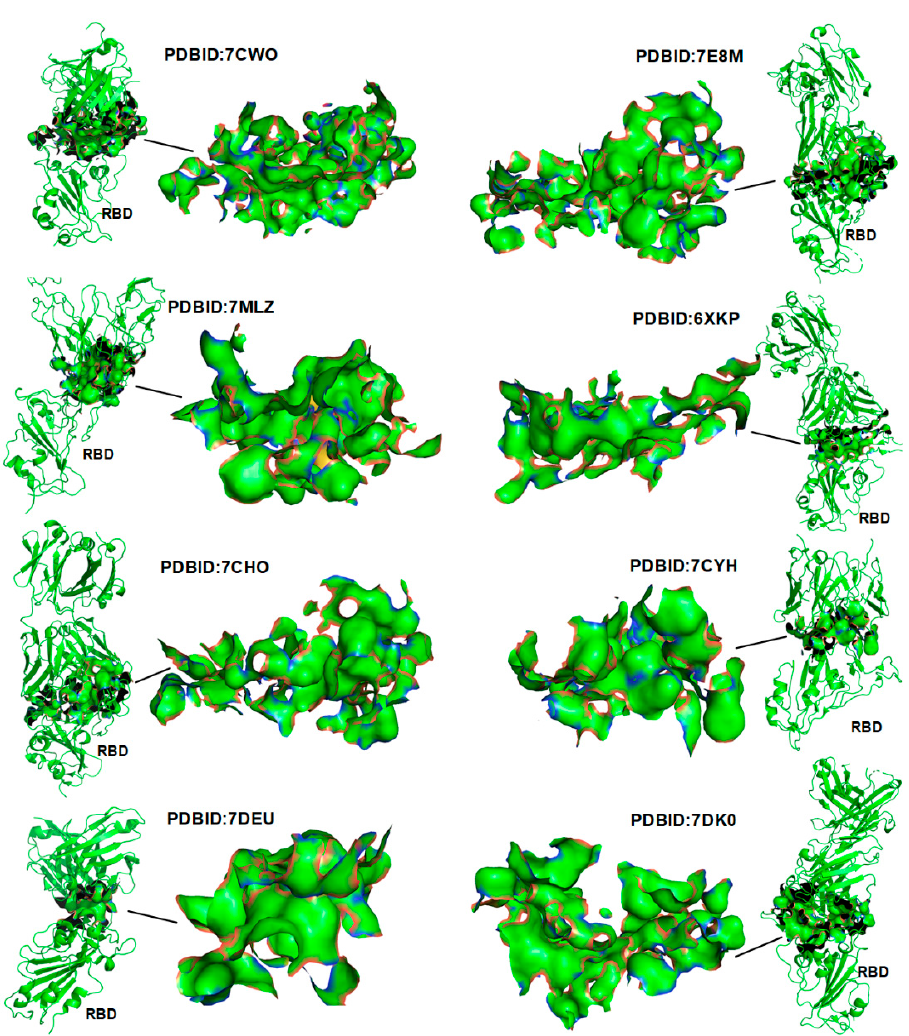
Figure 3. Strong hydrophobic–hydrophobic interactions at the interfaces of 8 RBD–antibody com- plexes. The distribution of hydrophobic surface areas are highlighted in green and